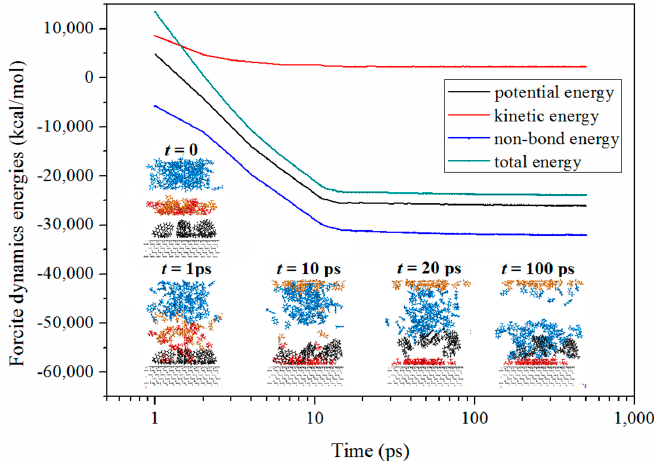
Figure 8. Consecutive snapshot of spontaneous desorption of asphaltene from a modelled carbonate asphalt rocks surface immersed in AAIL-toluene mixture and forcite dynamics energies of simulation system. Blue = toluene; red = cation of AAIL; orange = anion of AAIL; black = asphaltene and grey = calcite